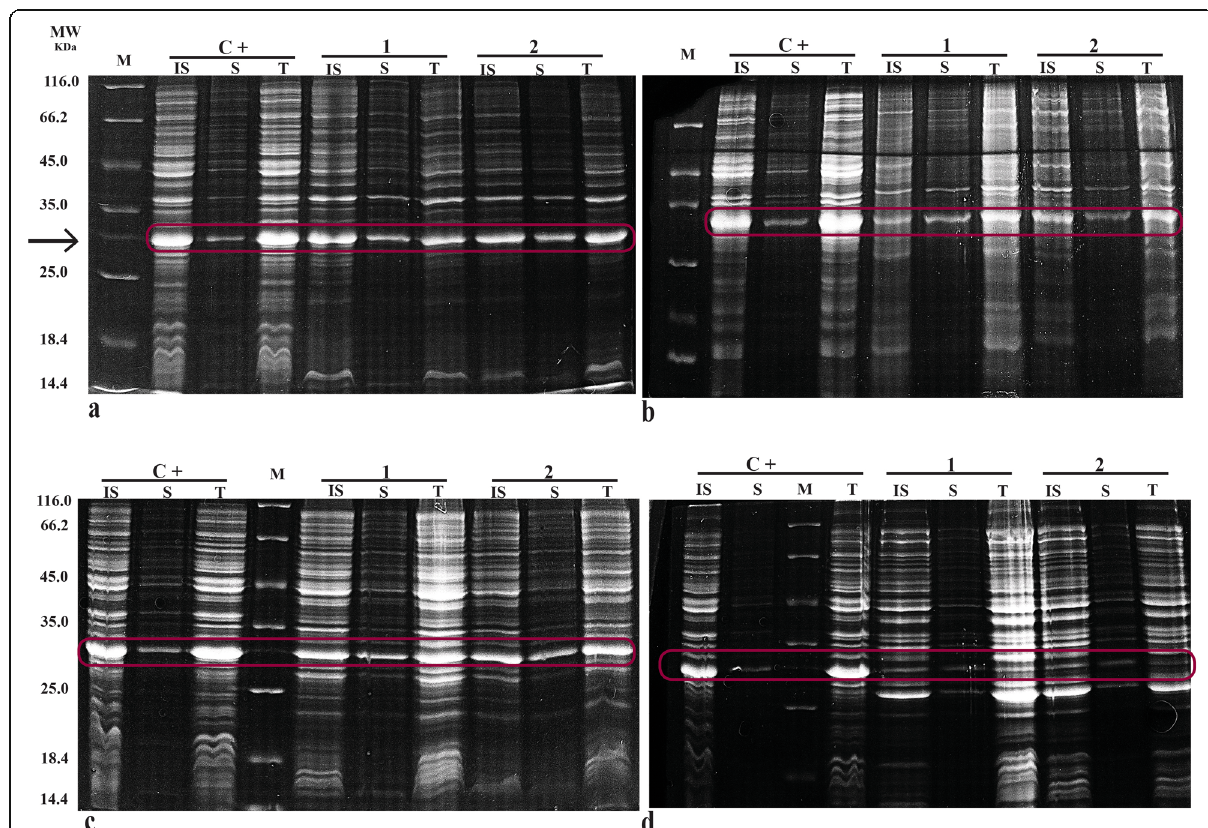
Fig. 3 Solubility assessment of anti-EpEX-scFv protein in four hosts. The total (T), soluble (S), and insoluble (IS) fractions of the expressed protein were prepared and subjected to SDS-PAGE. Bands related to anti-EpEX-scFv protein expressed in a BL21 TM (DE3), b Rosetta TM , c SHuffle TM T7, and d Origami TM (DE3) were visualized by coomassie brilliant blue staining. The experiments were performed in duplicates (1) and (2) for each strain. The positive control was E. coli K-12 BW25113 cells harboring the corresponding plasmid and was inducted by 0.8 mM IPTG at 37 °C for 24 h